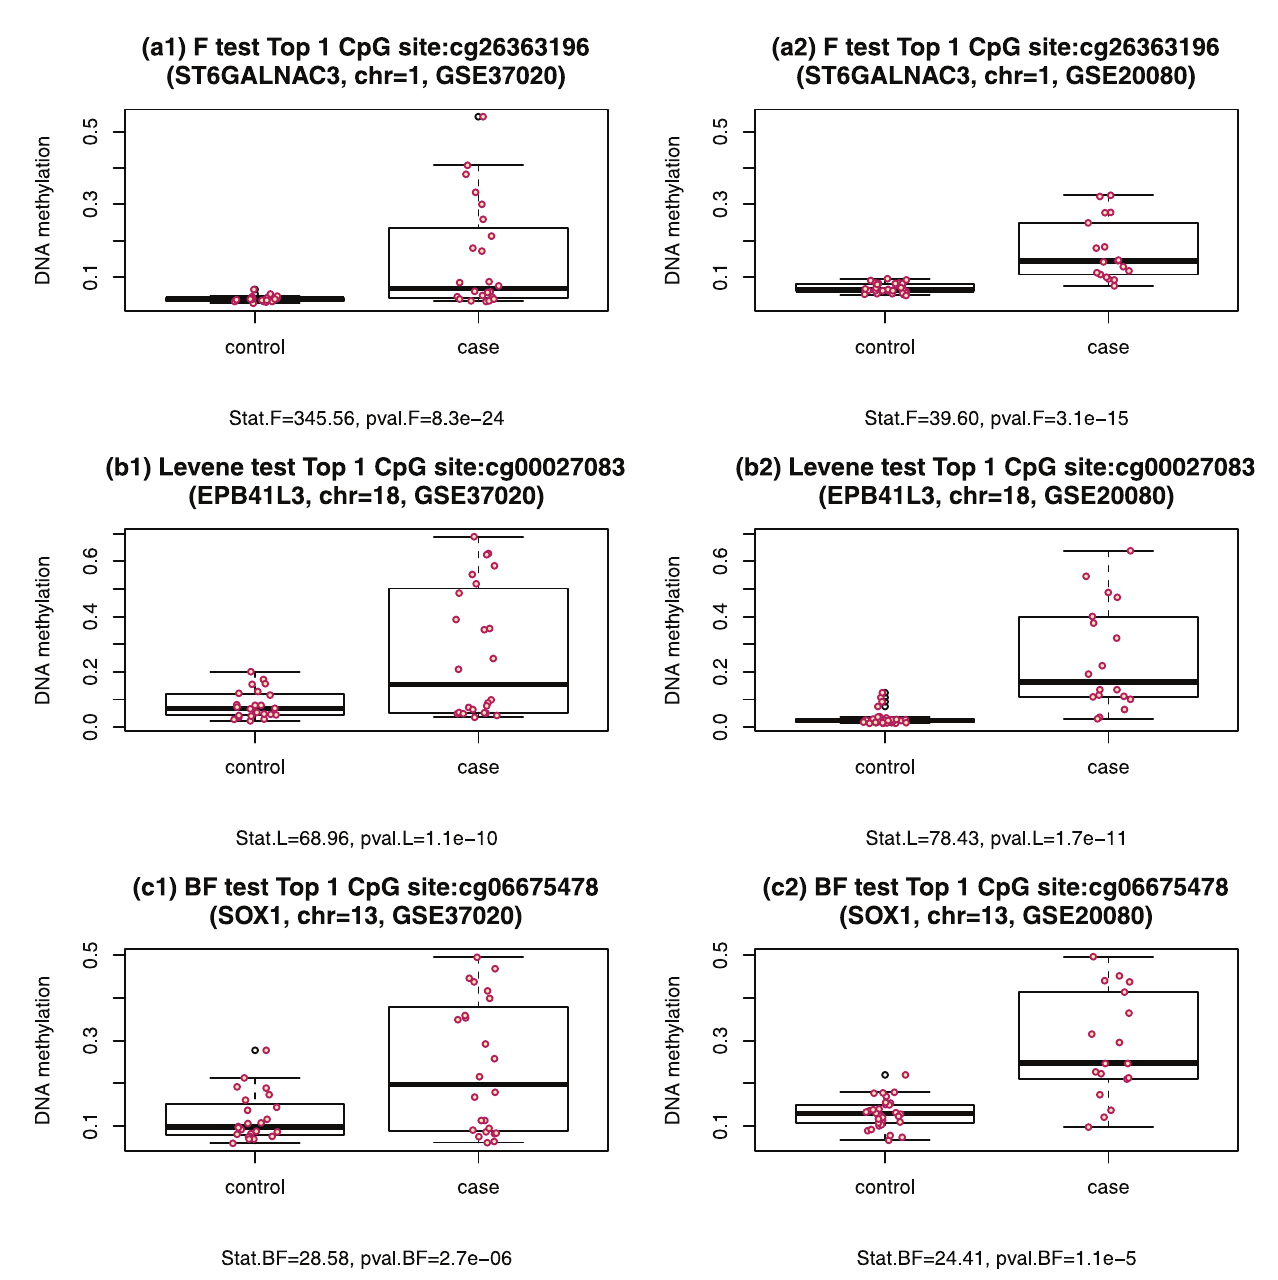
Fig 2. Paired parallel boxplots of DNA methylation level versus case-control status for the 4 unique top 1 CpG sites obtained by the 7 equal- variance tests based on GSE37020. The red dots indicate subjects. 2a1, 2b1, 2c1 are for cg26363196 (F), cg00027083 (Levene), and cg06675478 (BF), respectively, based on GSE37020; 2a2 2b2, 2c2 are for cg26363196 (F), cg00027083 (Levene), and cg06675478 (BF), respectively, based on